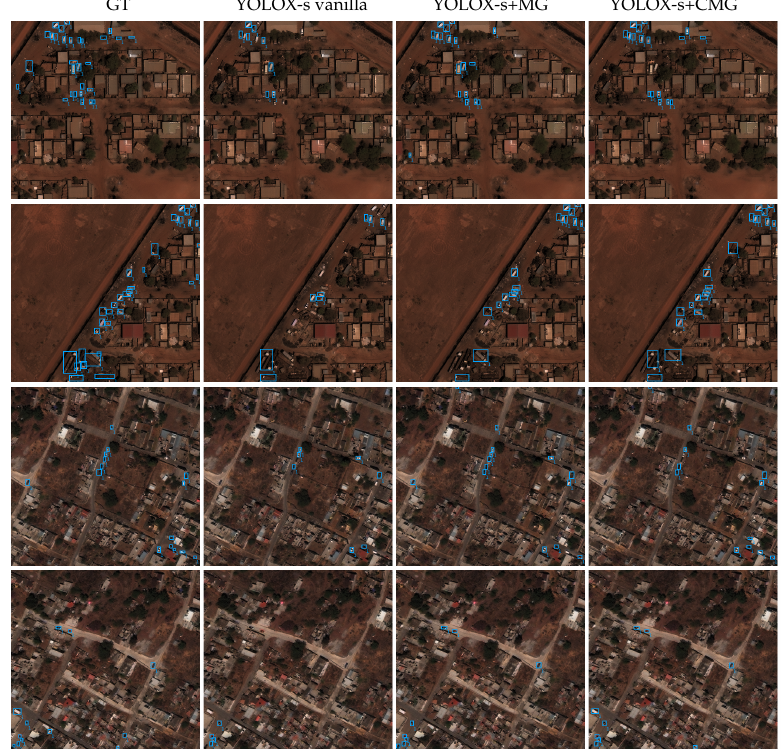
Figure 6. Qualitative results of YOLOX-s on xView. The contrastive mutual guidance helps to recognize intricate objects. The number and color of each box indicate the vehicle